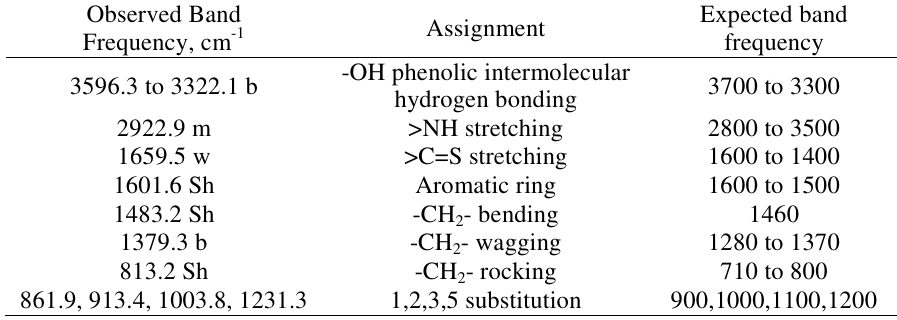
Table 1. IR spectral data of p -CDF terpolymer resin